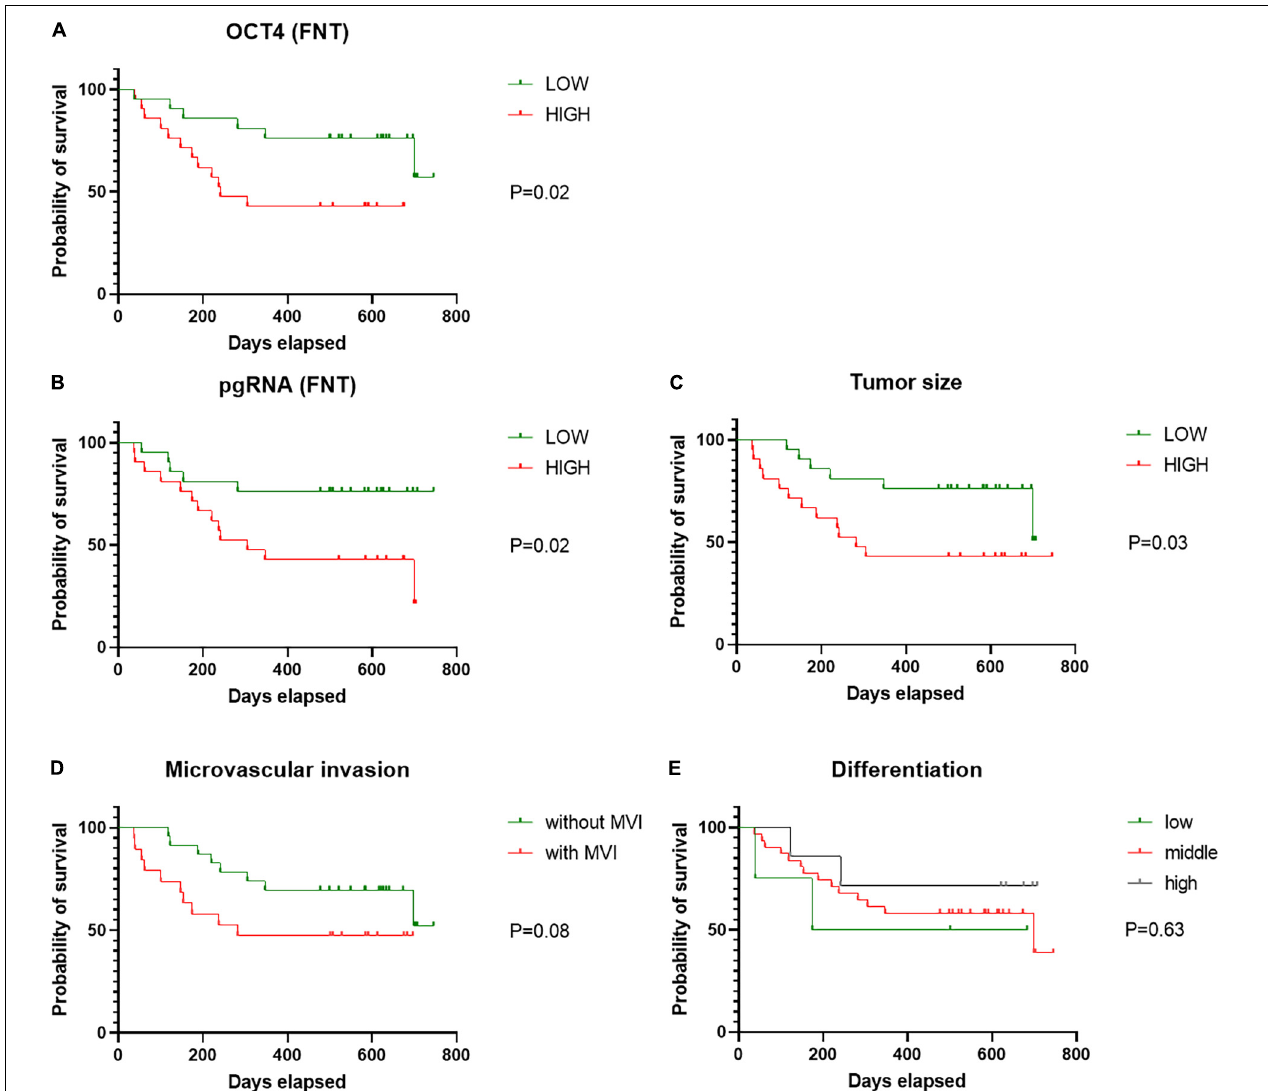
FIGURE 6 | Cancer recurrence of patients according to pgRNA (FNT). Cancer recurrence of patients according to (A) OCT4 (FNT), (B) pgRNA (FNT), (C) tumor size, (D) mvi, and (E) differentiation. Statistical analysis was performed by log-rank test. FNT, distal non-tumor; mvi, microvascular invasion.